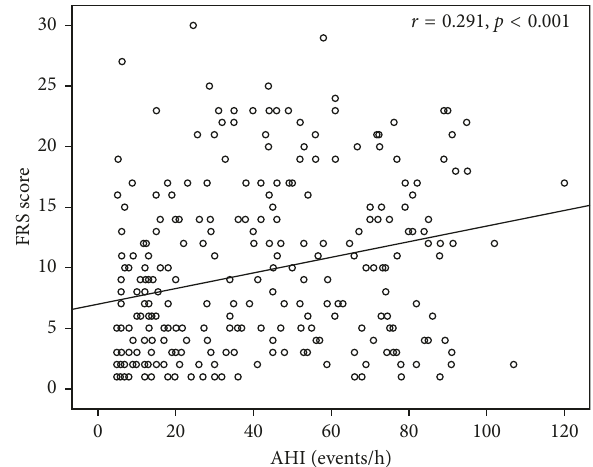
Figure 4: Correlation between Framingham Risk Score (FRS) and apnea-hypopnea index (AHI) in obstructive sleep apnea syndrome patients.